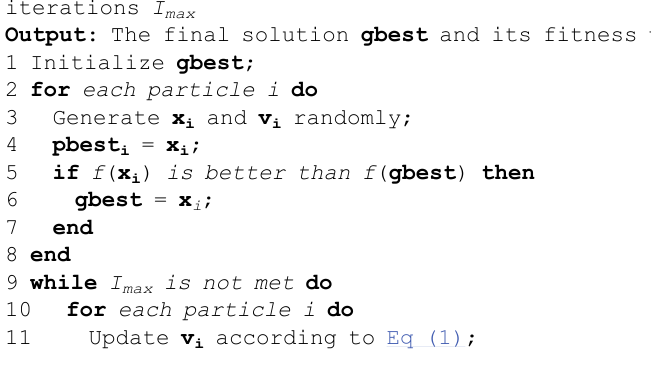
Algorithm 1 : Pseudo-code of CoPSO